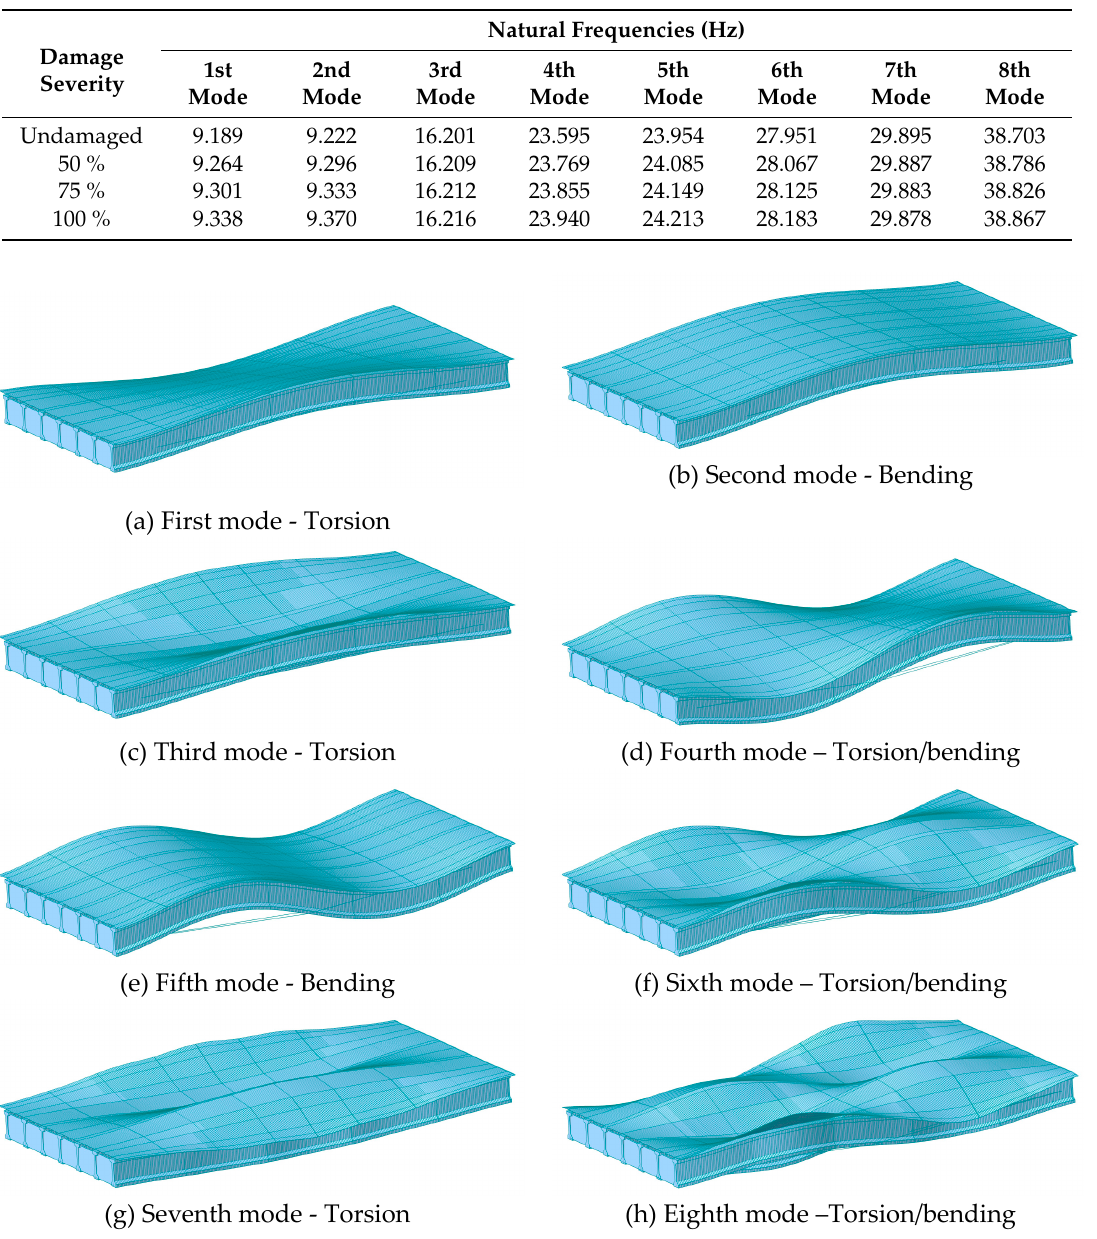
Table 2. Natural frequencies (Hz) of modelled bridge depending on the damage severity.